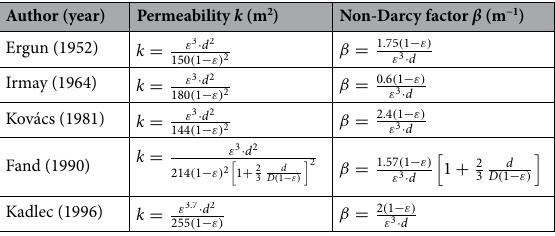
Table 2. The empirical expression of permeability and non-Darcy factor 20